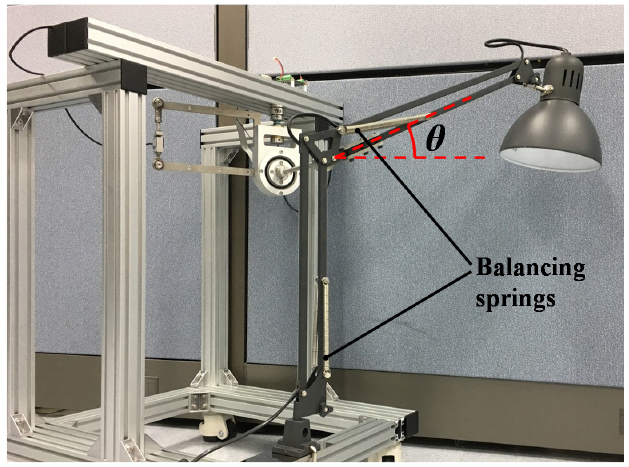
Figure 11. Experimental setup. An additional shaft is installed for external torque transmission.